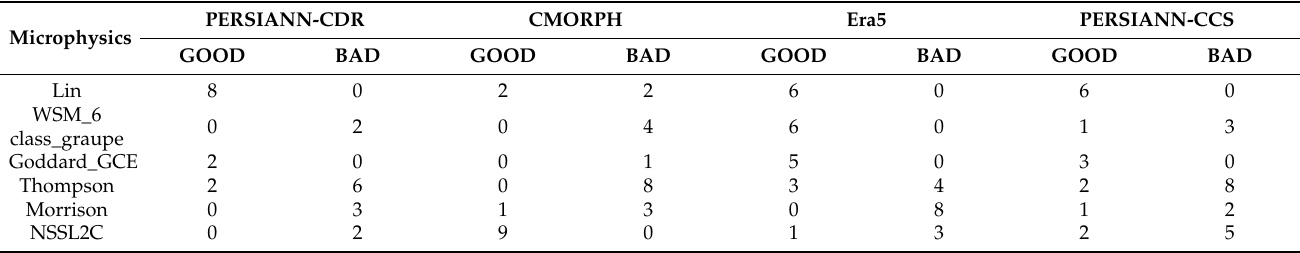
Table A5. Sum of GOOD and BAD scores for 24hr of accumulated